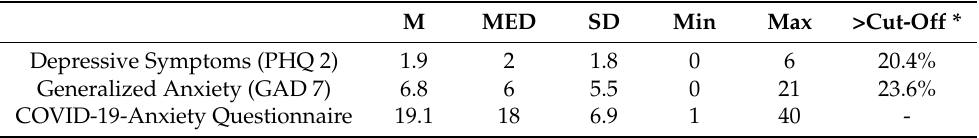
Table 2. Descriptive data mental health measures ( n =